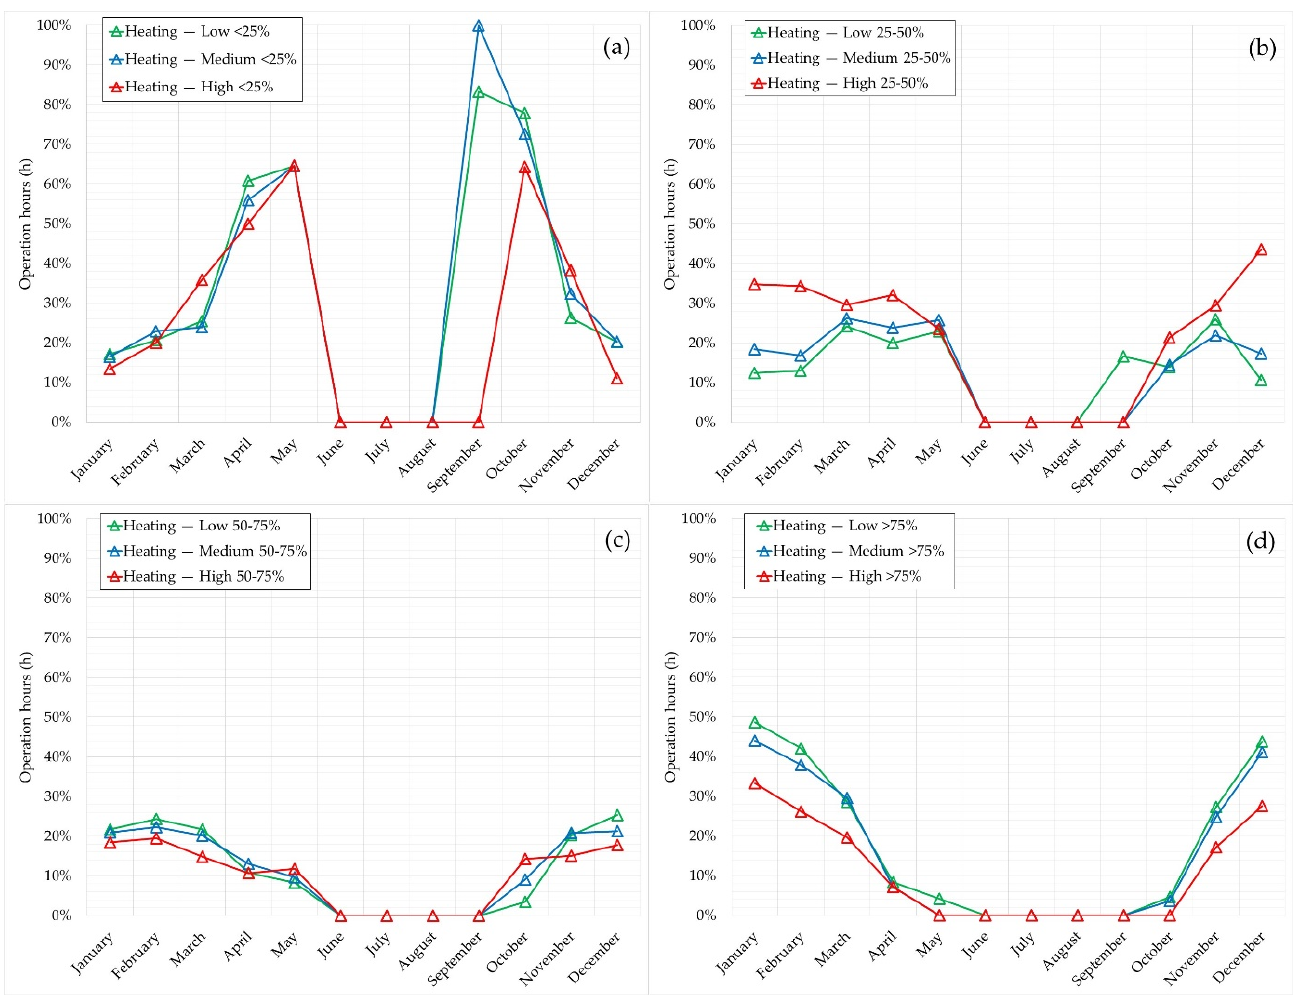
Figure 14. Operation hour percentage (%) during the heating season for different load factor ranges and profiles: ( a ) lower than 25%, ( b ) between 25 and 50%, ( c ) between 50 and 75%, and ( d ) greater than